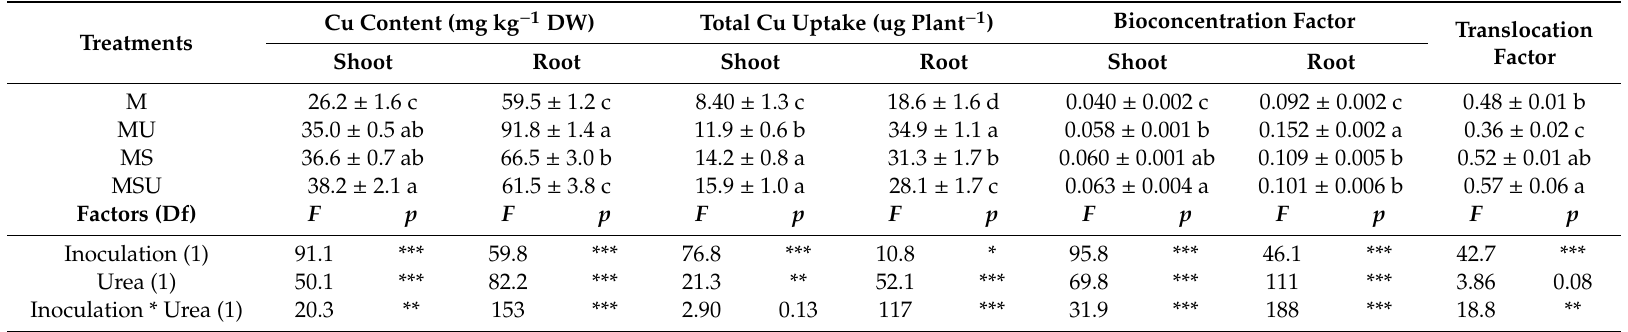
Table 6. The variation of Cu content, uptake, and transfer coe ffi cient in plants.